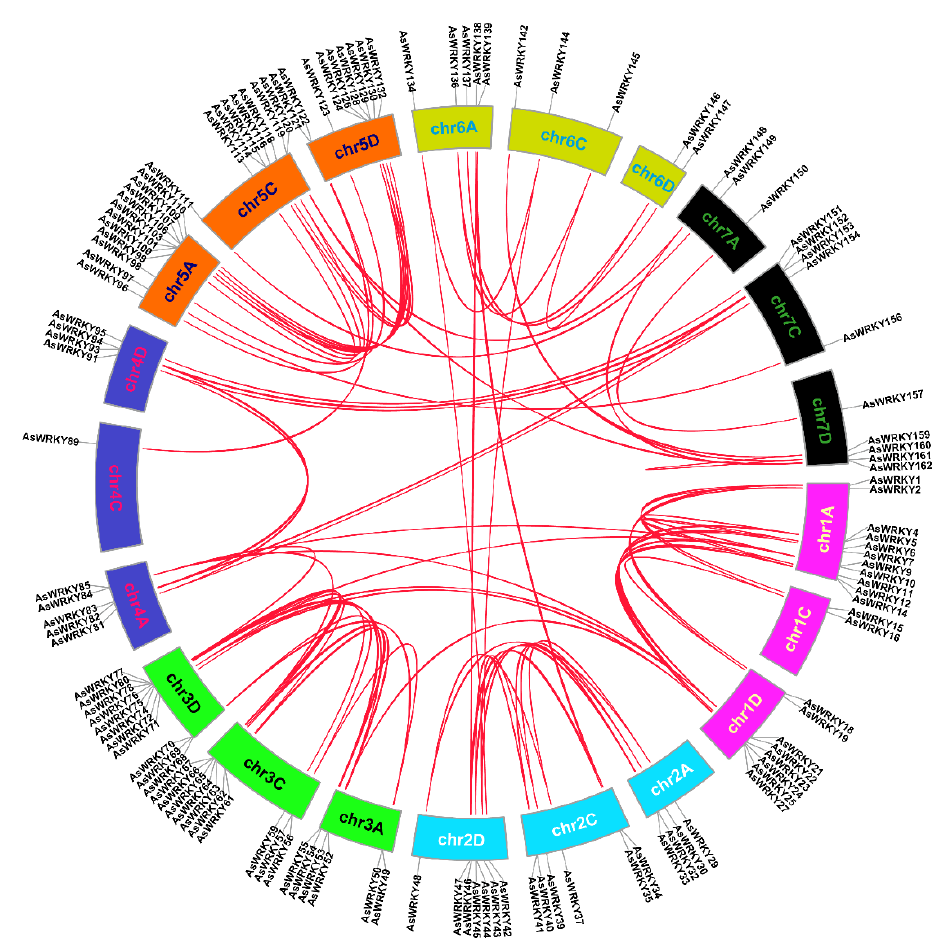
Figure 5. Synteny analysis of AsWRKY genes in oat. The red lines represent segmental duplication gene pairs. Chromosomes 1 – 7 are shown in different colors.